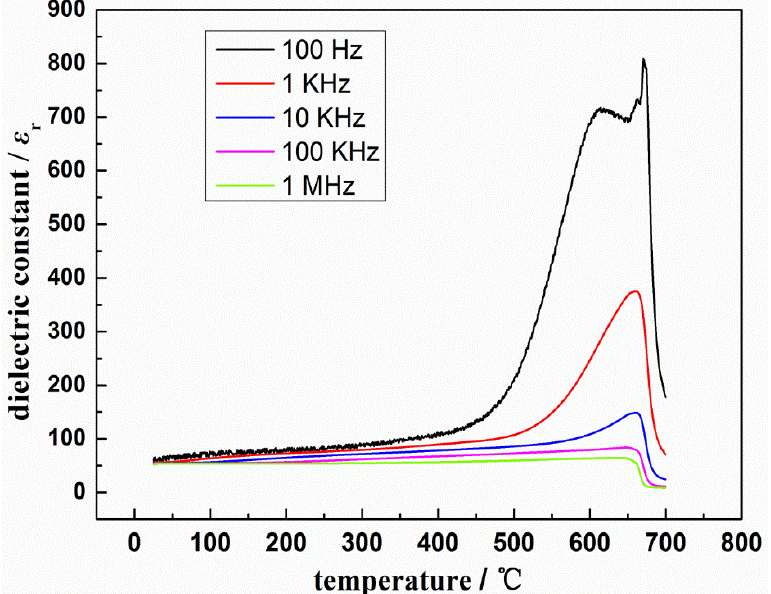
Figure 3. Temperature dependent ε r at different frequencies of La 0.9 Sr 0.1 TiO 3+δ